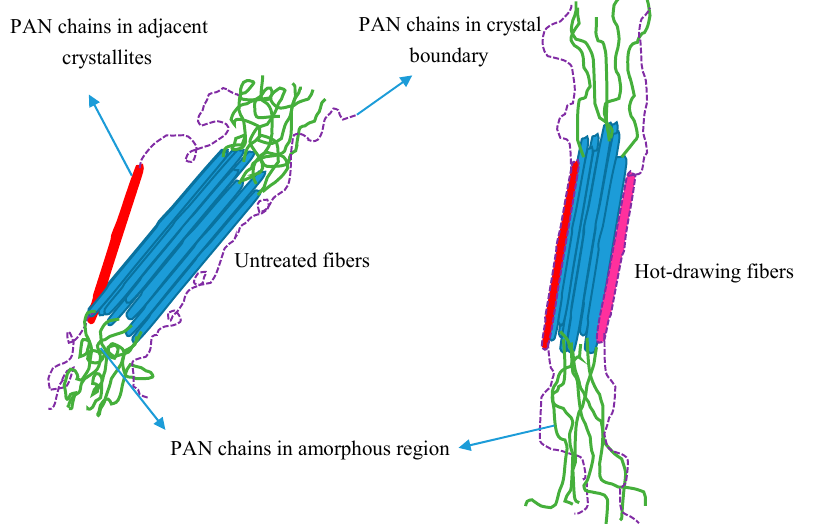
Figure 7. Schematic diagram of the change of crystallinity and the variation of chain segment in amorphous zone of fibers.